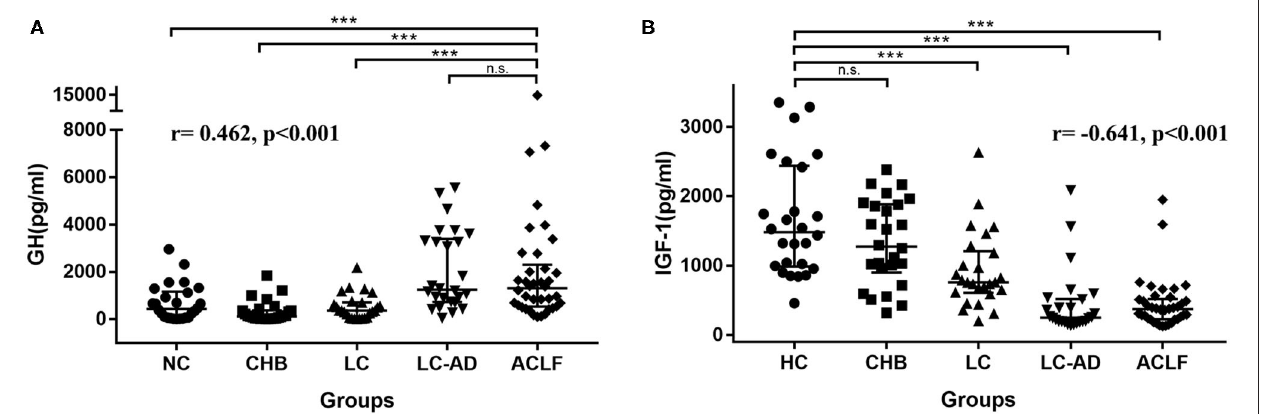
FIGURE 3 | Distribution of GH in cross-sectional cohort. (A) ACLF group showed higher GH levels than HC, CHB, and LC group, but no difference from LC-AD group, and the r -value of the correlation between GH levels and severity was 0.462, p < 0.001. (B) HC group showed higher IGF-1 levels than LC, LC-AD, and ACLF group, but no difference from CHB group, and the r value of the correlation between IGF-1 levels and severity was − 0.641, p < 0.001. ACLF, acute-on-chronic liver failure; CHB, chronic hepatitis B; GH, growth hormone; HC, health control; IGF-1, insulin-like growth factor-1; LC, liver cirrhosis; LC-AD, liver cirrhosis-acute decompensation. *** <